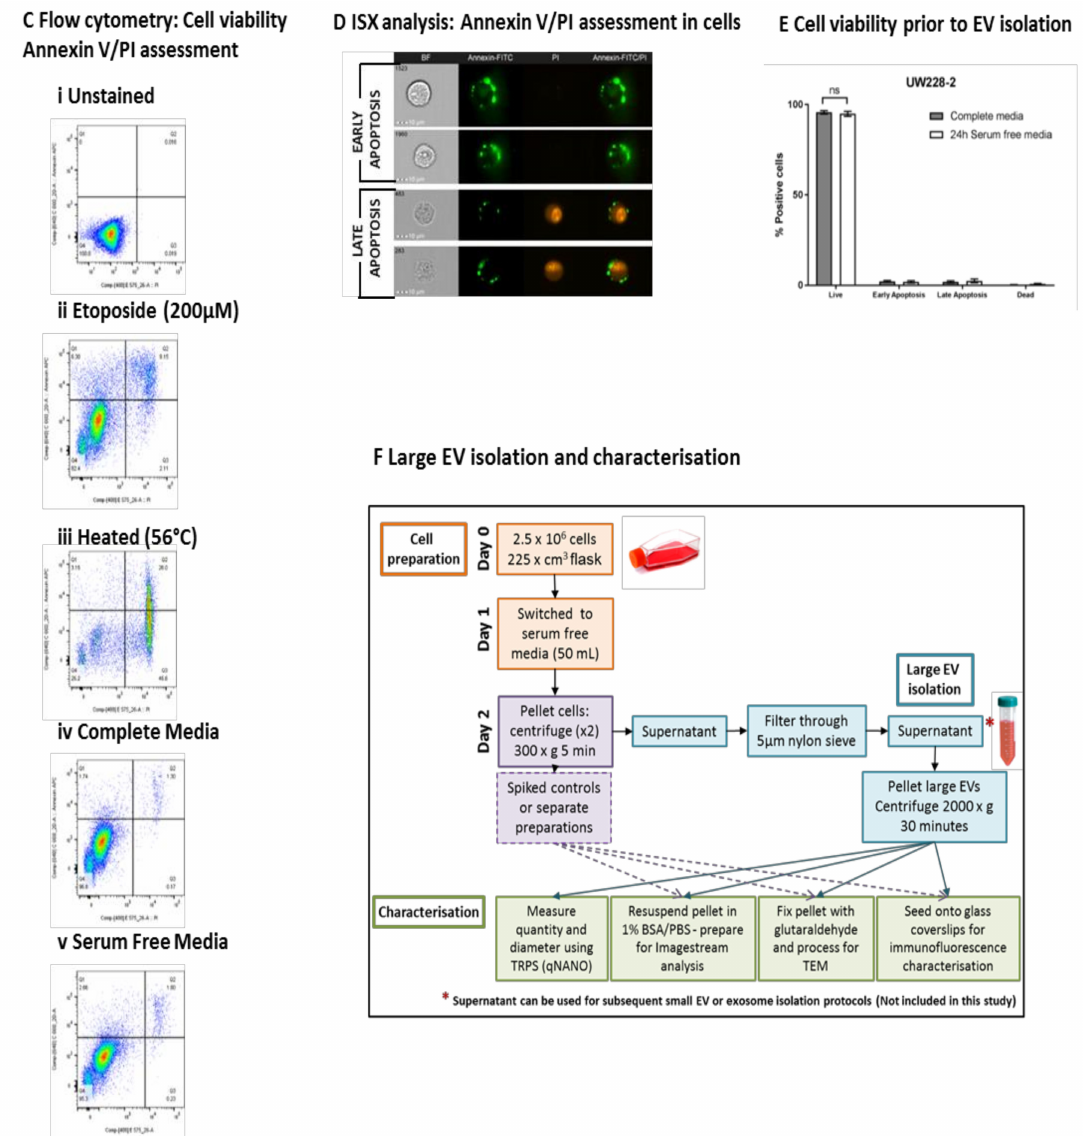
Figure 1. Immunofluorescence: UW228-2 cells and large extracellular vesicles (EVs) are CD63 + . Medulloblastoma cell lines produce large extracellular vesicles (EVs) which can be harvested from serum-free conditioned media after 24 h. ( A ) Medulloblastoma cells produce EVs in vitro which contain polymerised actin and CD63, but no nucleus. The medulloblastoma cell line UW228-2 was cultured on glass bottom plates for 24 h; fixed and probed for the tetraspanin and EV marker CD63 (FITC—green). Polymerised actin was labelled using Alexa Fluor 555 phalloidin (f-ACTIN—red). Nuclei were counterstained with DAPI (DAPI—blue). Images of large EVs (yellow arrows) and cells were captured using the Perkin Elmer Operetta system at × 40 magnification. The individual images were captured in black and white using the appropriate emission filters and a coloured composite image created using Columbus software. Scale bar represents 20 µ M. ( B ) Transmission electron microscopy: UW228-2 cell and adjacent large EV with limiting membrane. Large EVs have a limiting membrane, contain organelles but no nucleus and are < 6 µ m in size. Cells and EVs were applied to Poly-D-lysine coated ACLAR film and fixed with glutaraldehyde before processing for Transmission